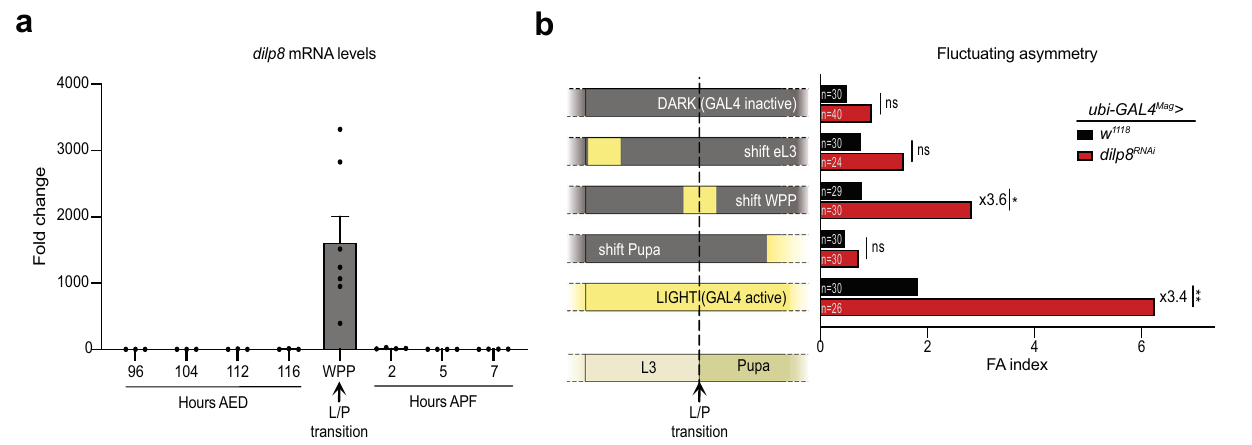
Fig.2|ApeakofDilp8expressionattheL/Ptransitionisrequiredfororgansize adjustment. a Measurement of dilp8 mRNA levels by qRT-PCR on whole animals ( w 1118 ascontrolstrain)attheindicatedtimepointsduringdevelopment.Valuesare expressed as fold changes relative to the 96h AED timepoint. Error bars represent SEM. The white prepupa stage (WPP) corresponds to 0h APF and marks the L/P transition. n =3 biologically independent samples were analyzed for the 96 – 116h AED time points, n =7 for WPP and n =4 for the 2 – 7h APF stages. b Temporal downregulation of dilp8 using the Shine-GAL4 system, in which the ubi-GAL4 Mag driverisactivateduponlightexposure.Theschemeontheleftdepictsthedifferent light shifts. Yellow periods mark the developmental times at which animals were